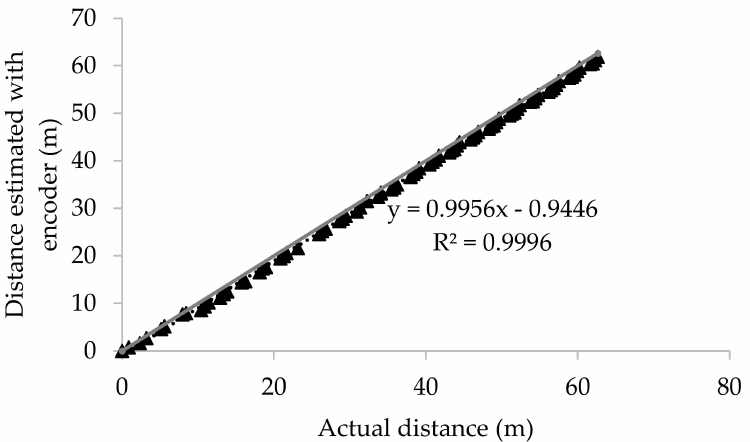
Figure 12. Controller–estimated distance travelled using the rotary encoder vs. actual distance travelled. The black triangles represent the encoder values, while the grey line represents a 1:1